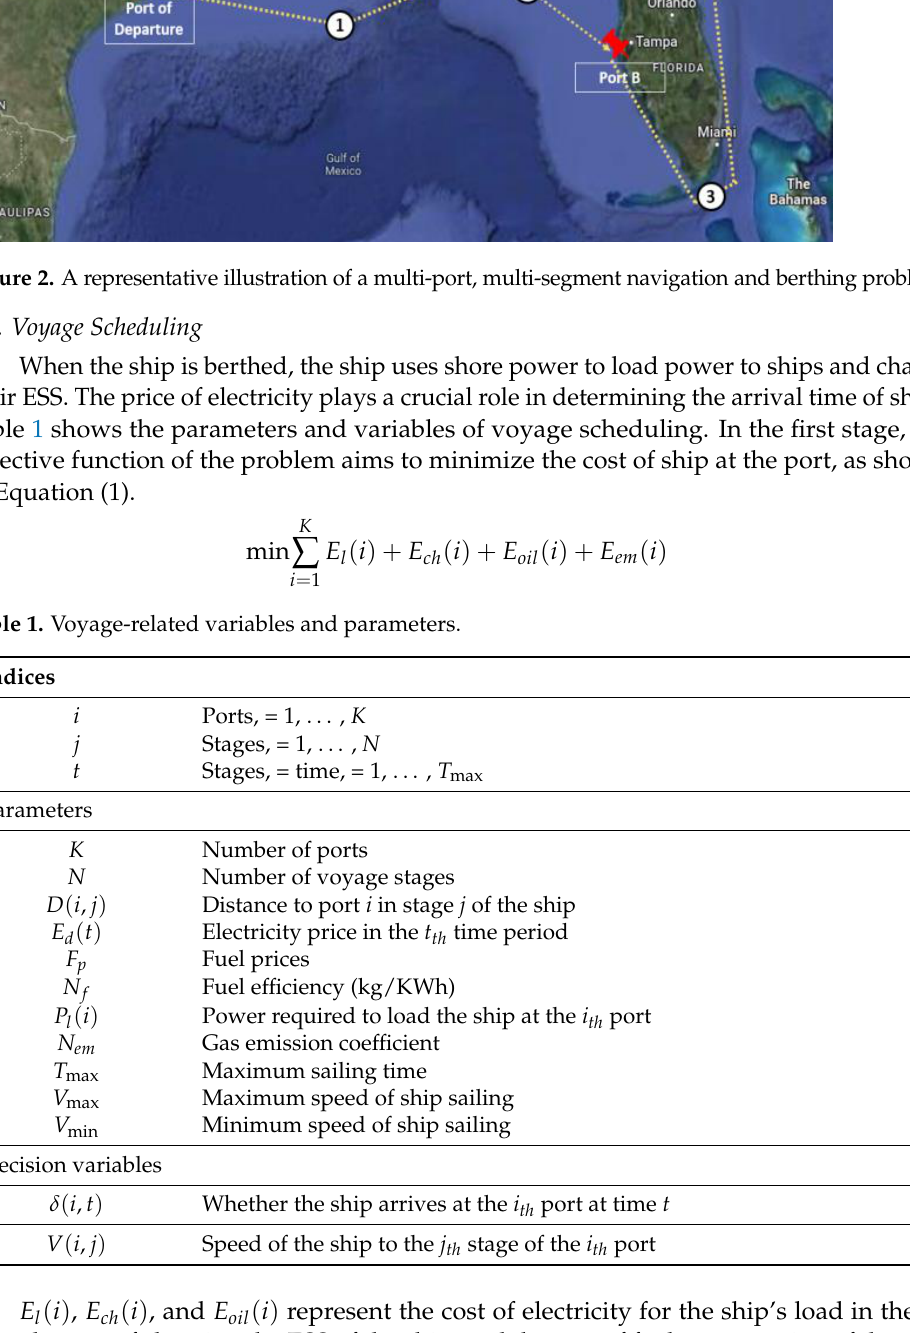
Table 1. Voyage-related variables and parameters.